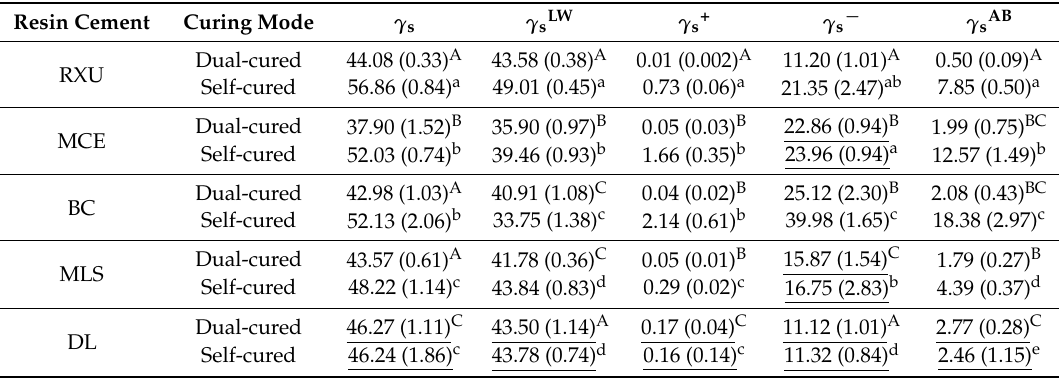
Figure 2. Degree of hydrophilicity (expressed as Δ G sws ) of the resin cements tested ( n = 5). The same upper- and lower-case letters indicate statistically similar means within the dual- and self-cured specimens, respectively ( p > 0.05). The horizontal bars connect statistically similar means between the two curing modes within each material ( p > 0.05).